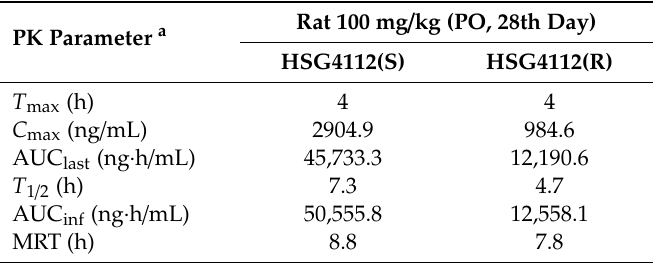
Figure 2. Plot for time-plasma concentration of HSG4112 after ( A ) oral (100 mg / kg / day, 28 th day, n = 3) and ( B ) iv (10 mg / kg, single dose, n = 3) administration in rats. Table 1. Pharmacokinetic parameters of HSG4112(S) and HSG4112(R) after PO administration at a repeated dose of 100 mg / kg / day to rats.